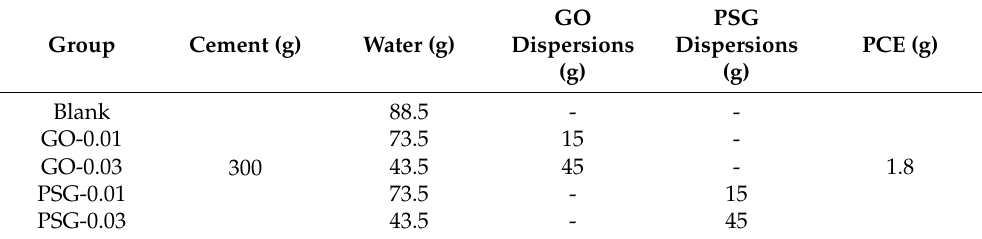
Table 3. Composition of cement-compound